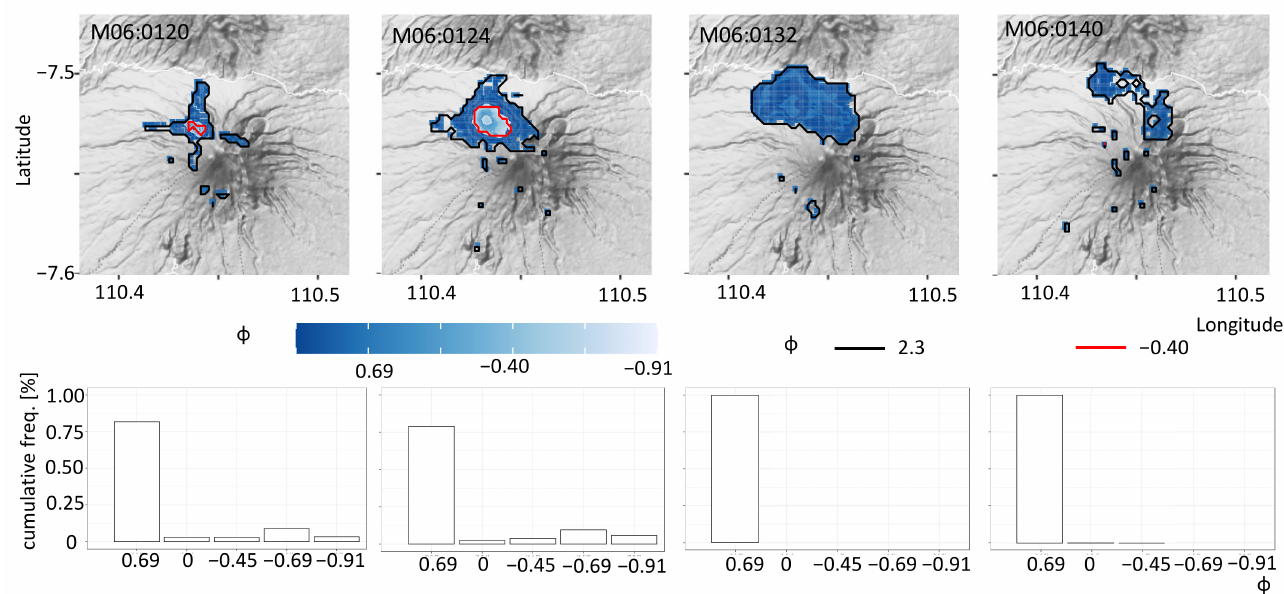
Figure 3. The first row is the spatial distribution of the estimated radar-retrieved mean diameter of M05 at different time stamps. The second row is the corresponding cumulative grain size (in φ ) for each time stamp. In each image on the second row, the x -axis is the lower limit of φ = − log 2 D .